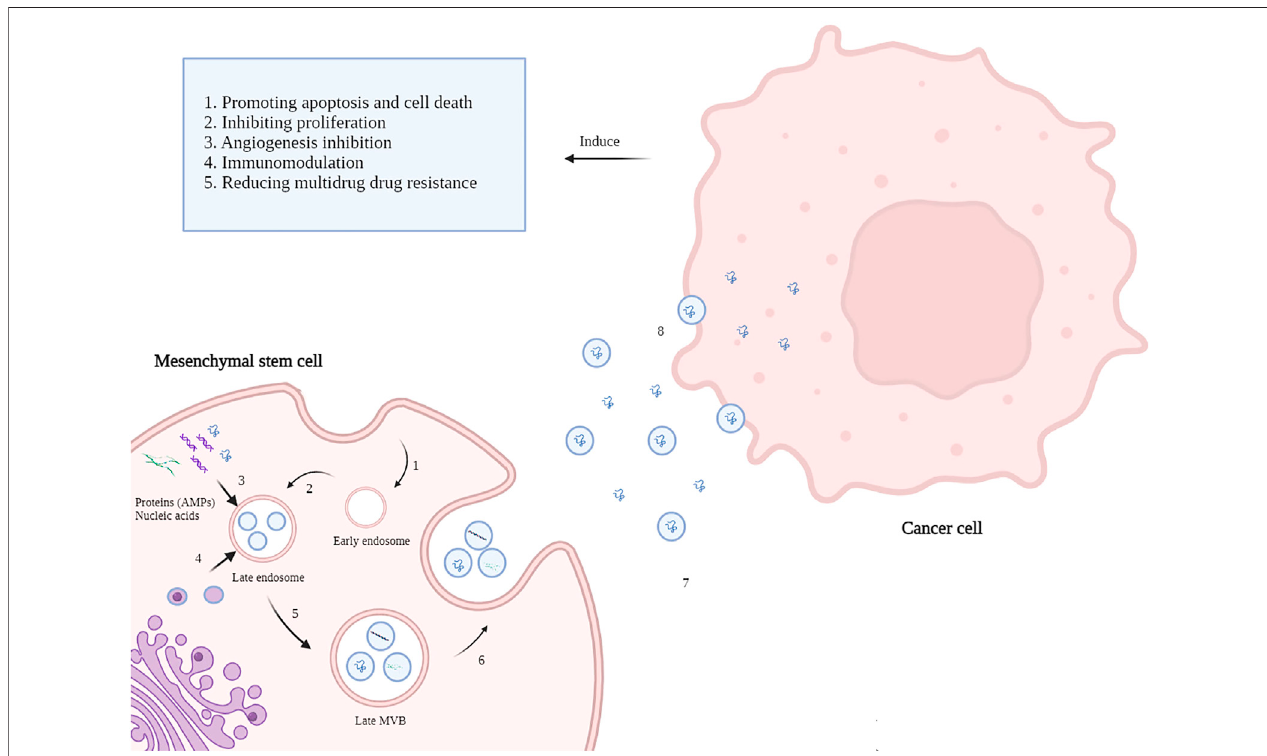
FIGURE 1 | Mechanisms of MSC-derived AMPs delivery to cancer cells. 1. The Inward budding of the MSCs membrane creates an early endosome. 2. Early endosomes then progress to late endosomes when intraluminal vesicles (ILVs) incorporate lipids, nucleic acids, and proteins like AMP appear. 3. Cellular contents of MSCs such as AMPs, MicroRNAs, and lipids enters late endosomes via inward budding of the endosomal membrane. 4. Late endosome cooperates with Golgi apparatus mutually. 5. Incorporation of cellular content fi nally forms multivesicular bodies (MVBs). 6. MVBs fuse with the MSCs plasma membrane and release the vesicular contents called exosomes. 7. Exosomes carry AMPs toward cancer cells alongside the soluble AMPs in the tumor microenvironment. 8. Exosomes transfer their content to the cancer cells and induce anti-neoplastic effects (created by biorender.com).